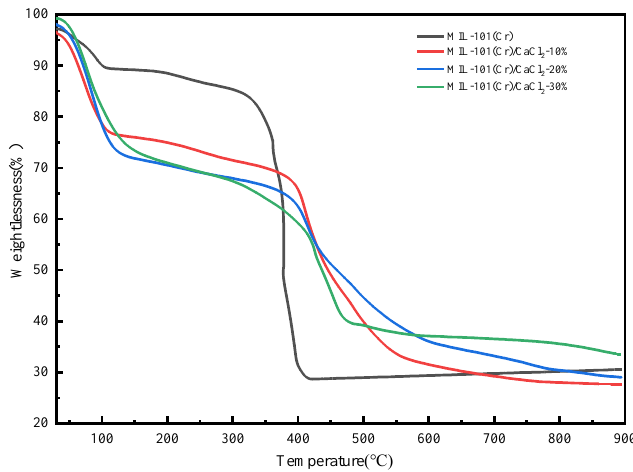
Figure 2. Thermogravimetric TG curve of MIL-101(Cr) and composites.